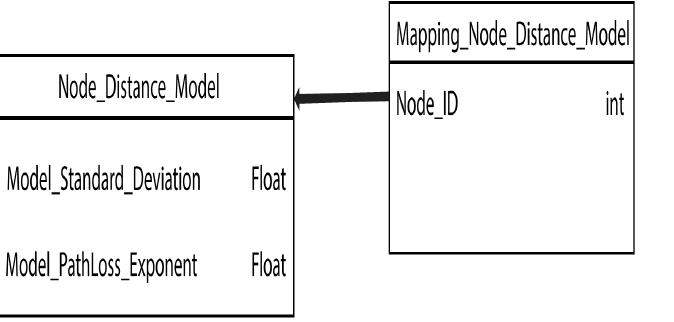
Figure 16. Mapping diagram illustrating how each consumer node is mapped to its own distance computation model in the Anchor server